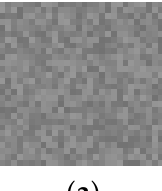
the EEG recognition task. Table 4. Algorithm